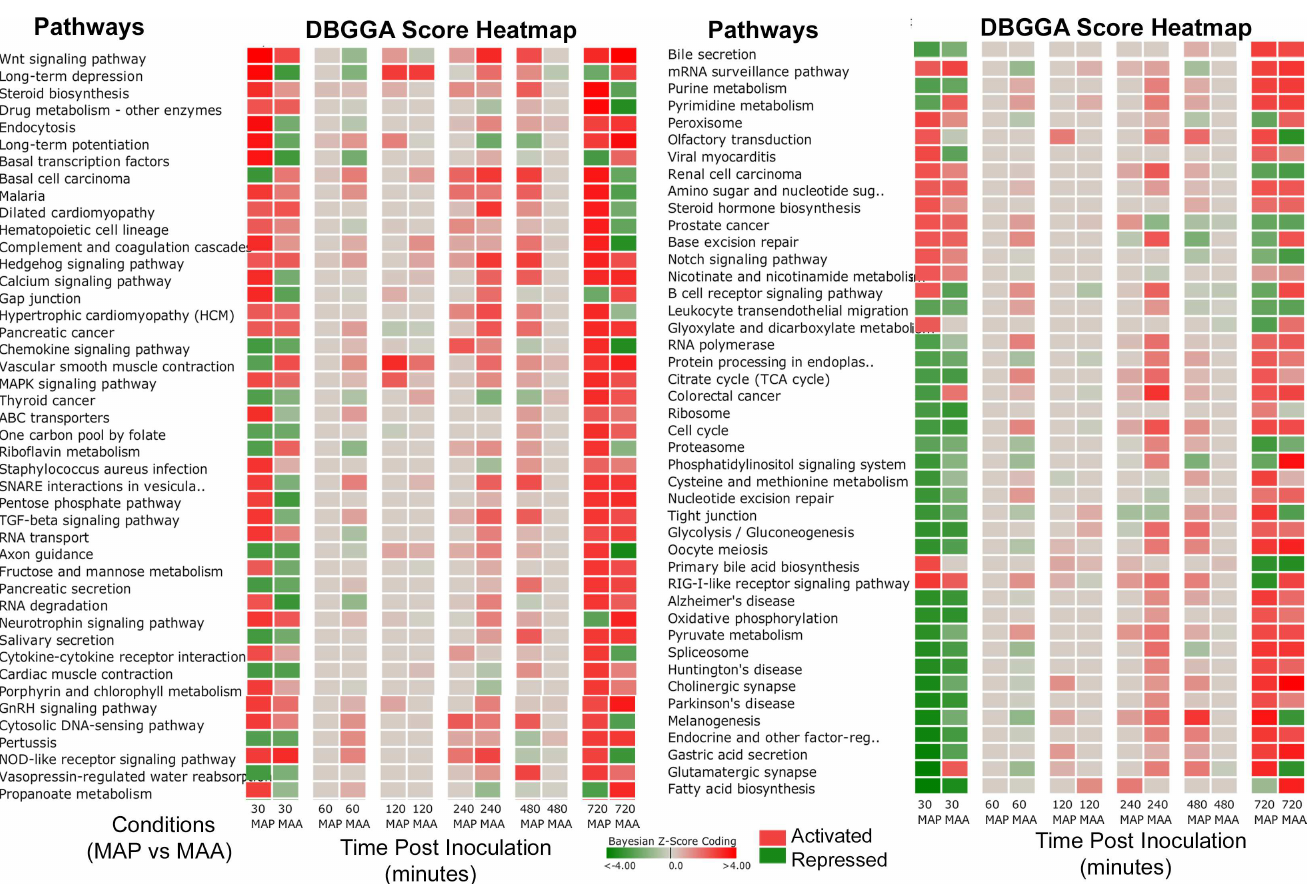
Fig 3. Heatmapof pathwayscoresof a side-by-sidecomparison (by time point)betweenMAP vs PBS versus MAA vs PBS. The heatmap comparesMAP significantly perturbed pathways to the MAA condition. The selectionof pathways was based on those that were found significant (DBGGAzscore (cid:21) 2.24)for the MAP conditionat 30 minutespost infection. Red indicatesactivation and green indicatesrepression.The gradient in color indicates magnitude of perturbation (i.e., higher|zscore|).